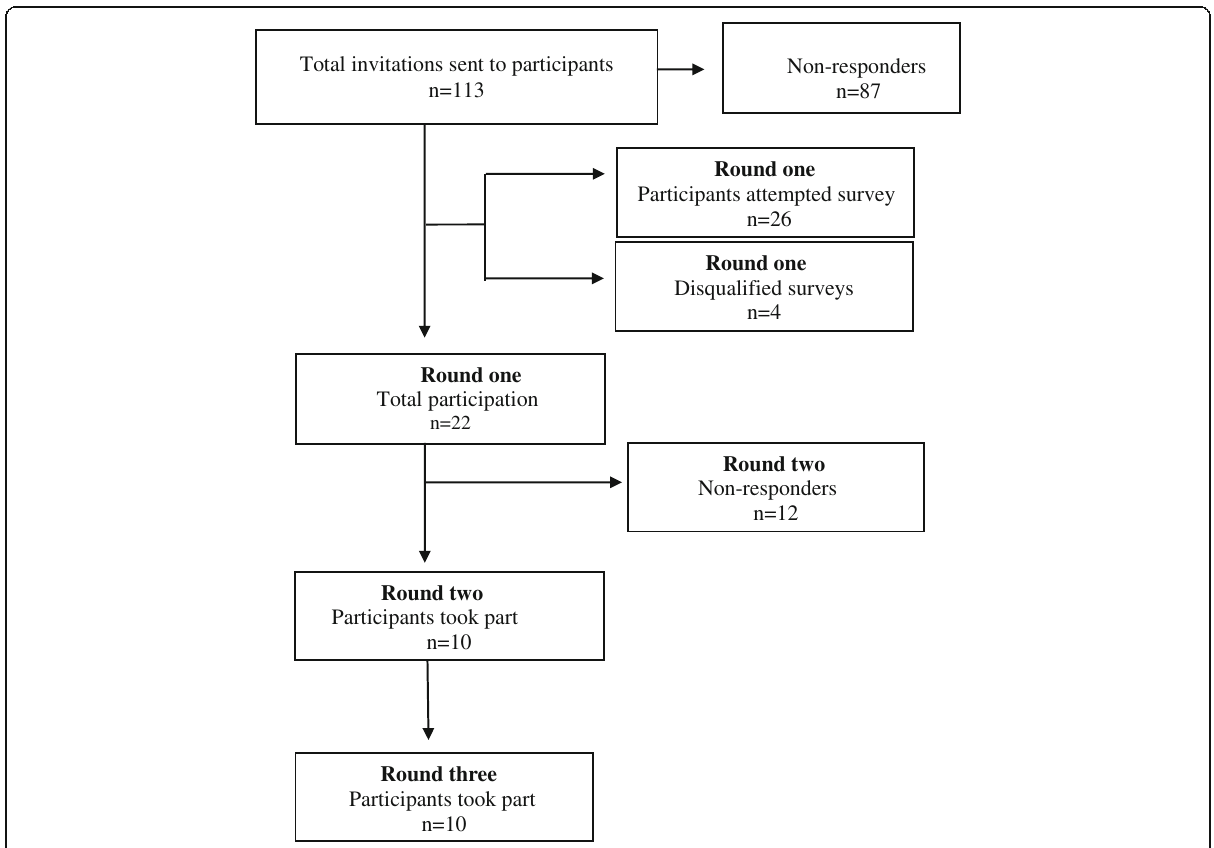
Fig. 2 Flow of participation from round one to round